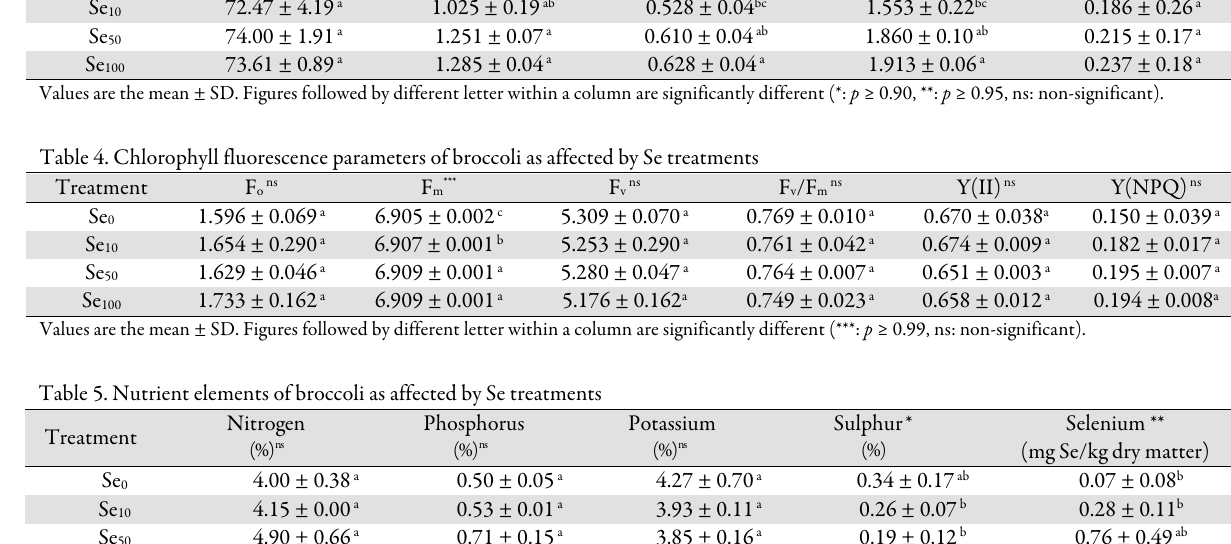
Values are the mean ± SD. Figures followed by different letter within a column are significantly different (*: p ≥ 0.90, **: p ≥ 0.95, ns: